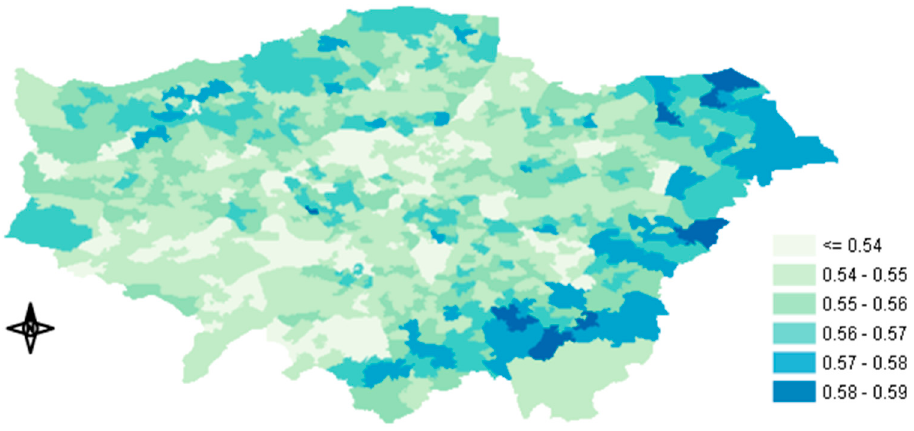
Figure 2. Map of annual average Indoor / Outdoor (I / O) ratios used in our study. Figure 2 . Map of annual average Indoor/Outdoor (I/O) ratios used in our study.